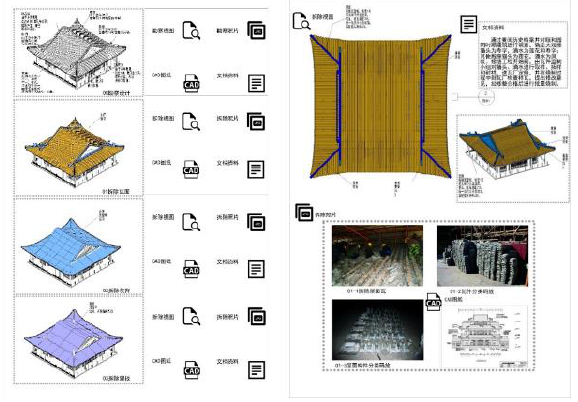
Figure.2 BIM technology application in Dehe Palace in the